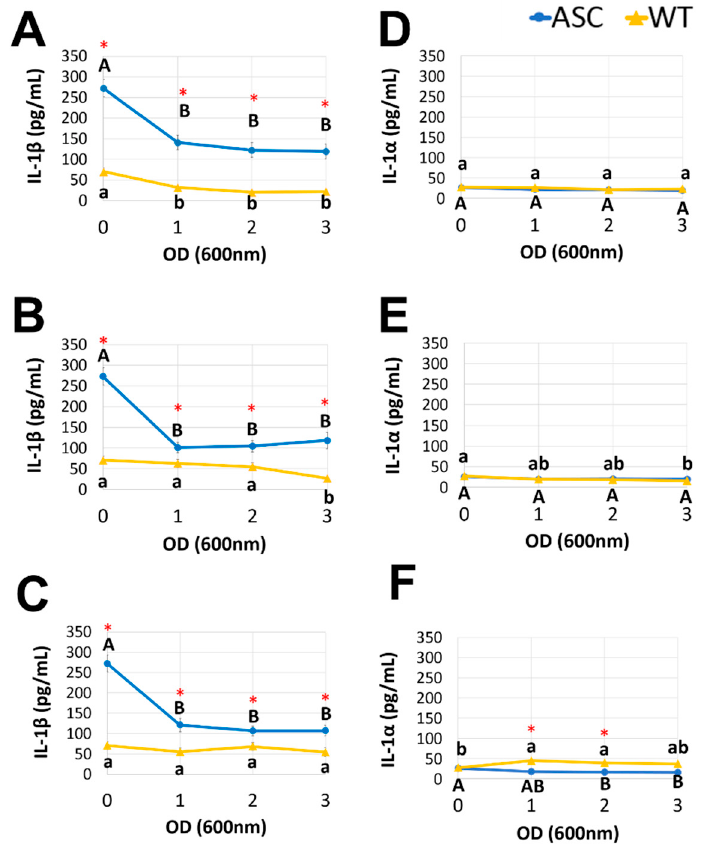
Figure 4. Postbiotics collected from LGG, L.reu, and BB12 suppressed the release of IL-1 β in the ASC, but not the WT cells. The cytokines, IL-1 β (panels A–C), and IL-1 α (panels D–F) were analyzed by ELISA in supernatants collected from the ASC and WT cells after LPS priming (20 ng/mL) and cSiO 2 stimulation (25 µg/mL). Prior to the LPS priming and cSiO 2 stimulation, 1 × 10 5 cells/well were pre-treated with postbiotics collected from OD 1–3 of LGG (panels A,D), BB12 (panels B,E), and L.reu (panels C,F). The data are presented as mean ± SEM; biological triplicates were conducted. The cells treated with the MRS only were used as a negative control for postbiotic pre-treatment (designated data point OD 0). The blue lines with circles represent the ASC cells and the yellow lines with triangles represent the WT cells. The capitalized letters indicate significant differences among ASC while the lowercase letters indicate significant differences among WT ( p < 0.05). * Indicates significant differences between ASC and WT ( p <